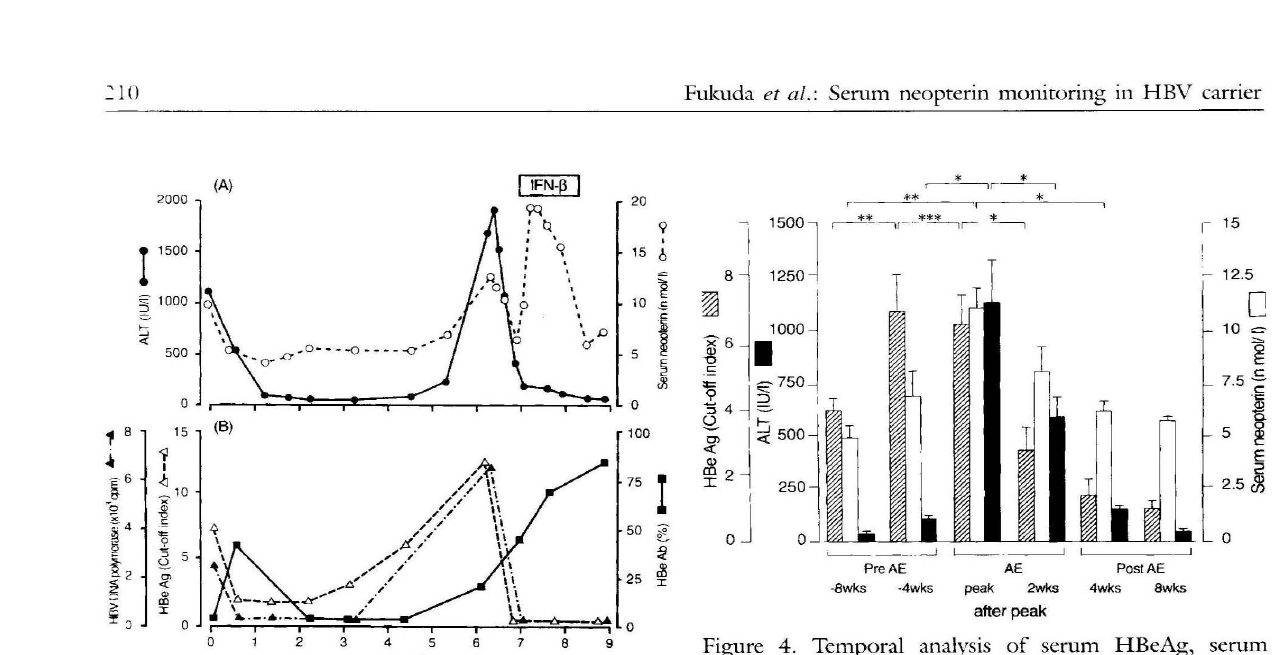
Figure 2. Time course changes of (A) serum neopterin k\TIs (nmol/I) and ALT value (IUjl), and (B) HBeAg cut-oft- index), HBV-DNA polymclase (cpm) and HBeAb 00' in a chronic hepatitis B patient (No.3) demonstrati~g the episodes of AE. The patient was treated with IFN-Ei .1ttcr the second AE.